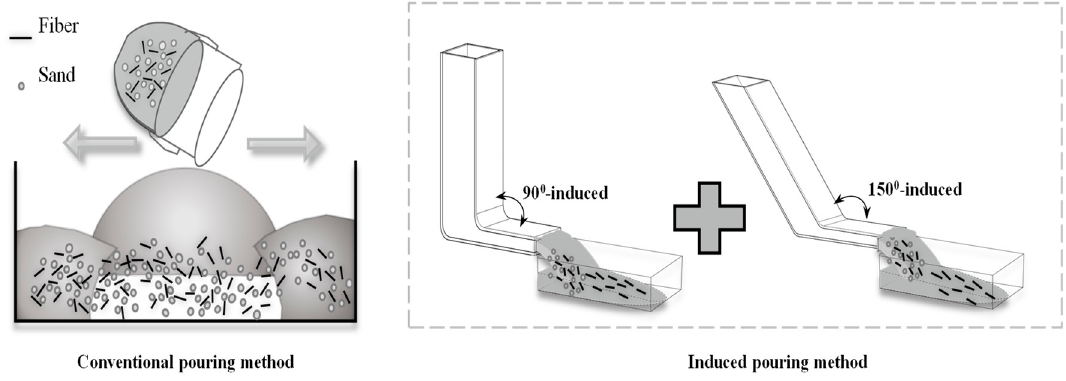
Figure 1. Different casting